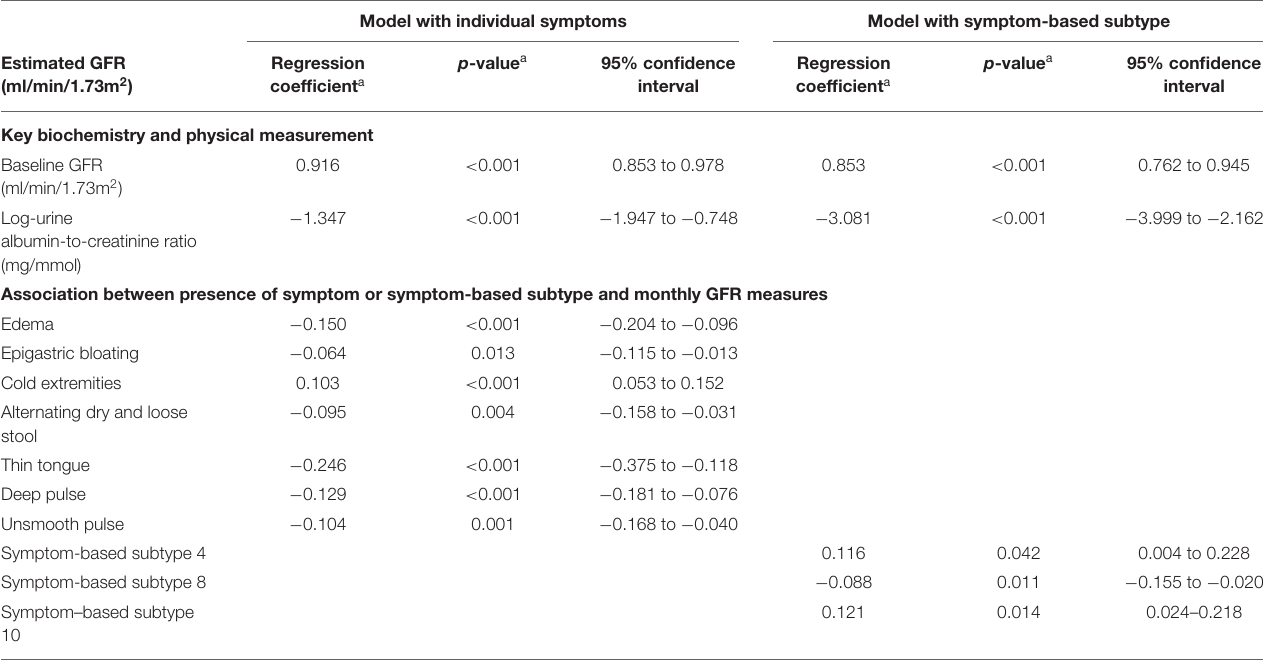
TABLE 5 | Longitudinal association between slope of glomerular filtration rate change, epidemiological factors, symptoms, and biochemical parameters by follow-up repeated